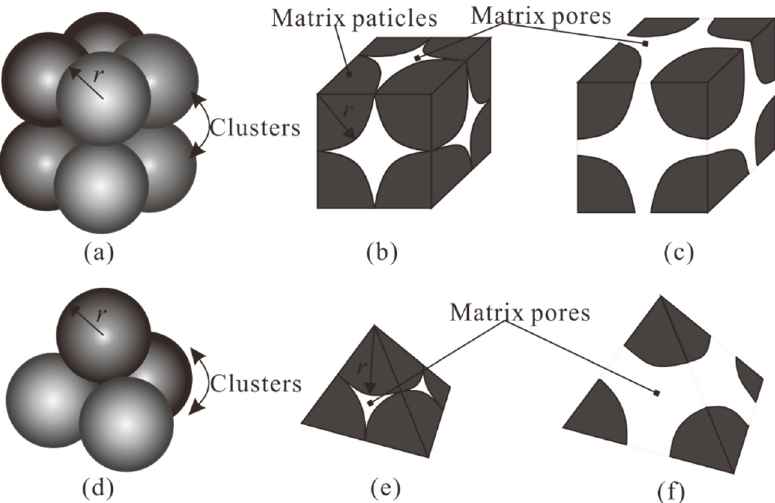
Figure 2. Schematic diagram of structural model of ideal pore space. ( a ) Arrangement of loose particles; ( b ) Ideal loose arrangement; ( c ) Conventional loose arrangement; ( d ) Compact particles arrangement; ( e ) Ideal most compact arrangement; ( f ) Regular compact permutation.